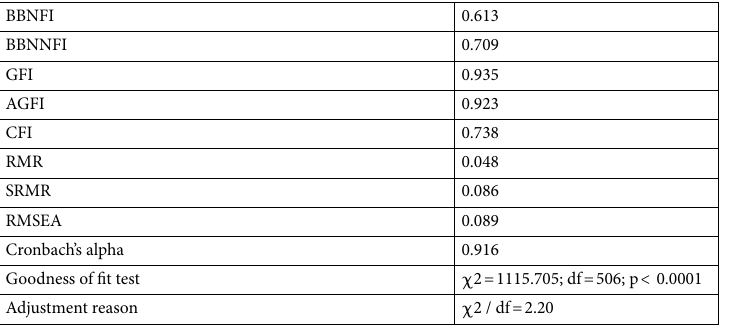
Table 1. Goodness-of-fit indices for the confirmatory model QPC-FIPS Spanish. BBNFI : Bentler bonnet normed fit index, BBNNFI Bentler Bonnet non-normed fit index, GFI Goodness of fit index, AGFI